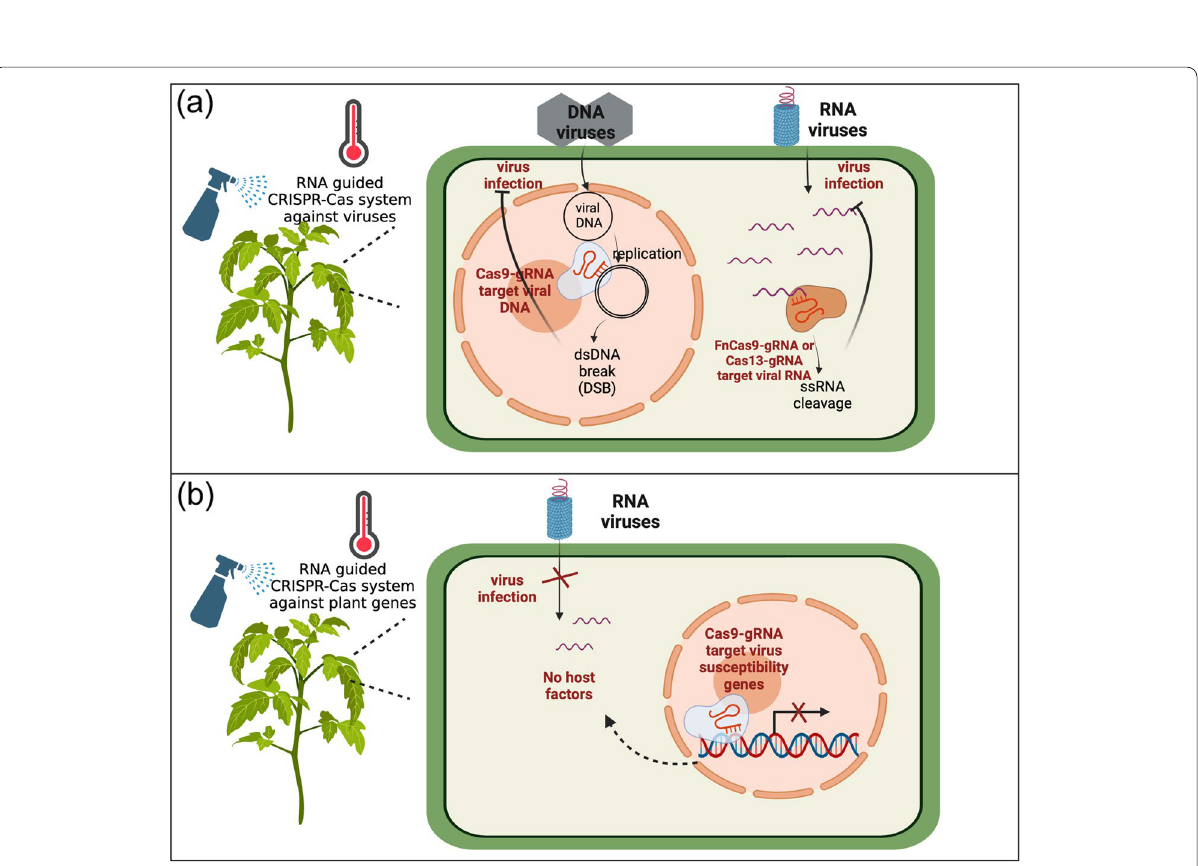
Fig. 4 Schematic representation of proposed exogenous application of RNA guided CRISPR‑Cas system to confer resistance to plant viruses. a CRISPR/Cas targets viral genomic DNA or RNA for destruction. b CRISPR/Cas targets virus susceptibility genes that are essential for viral infection of